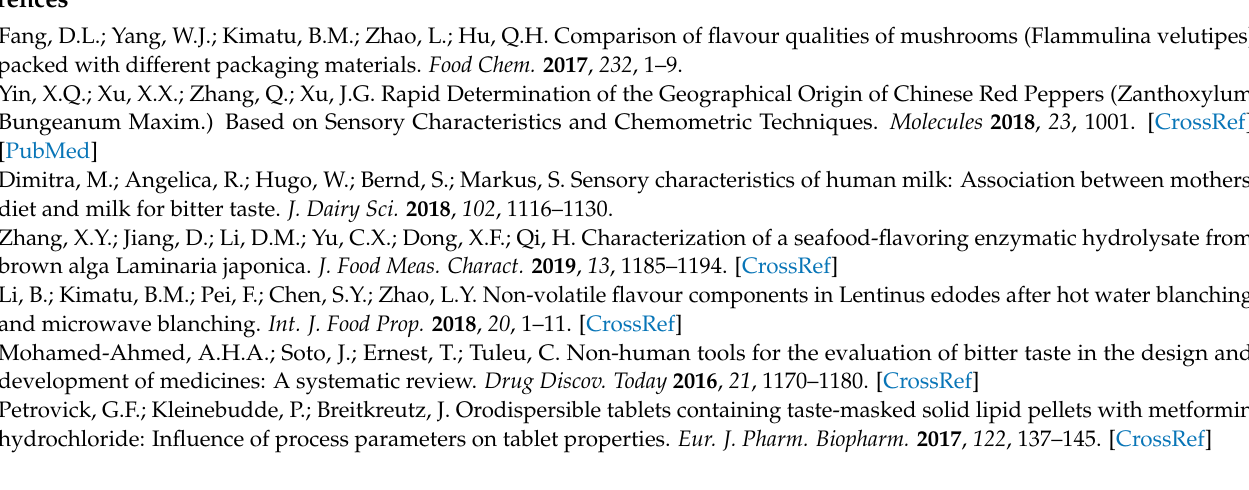
Table S3. Results of multi-component quantitative analysis and proportionate